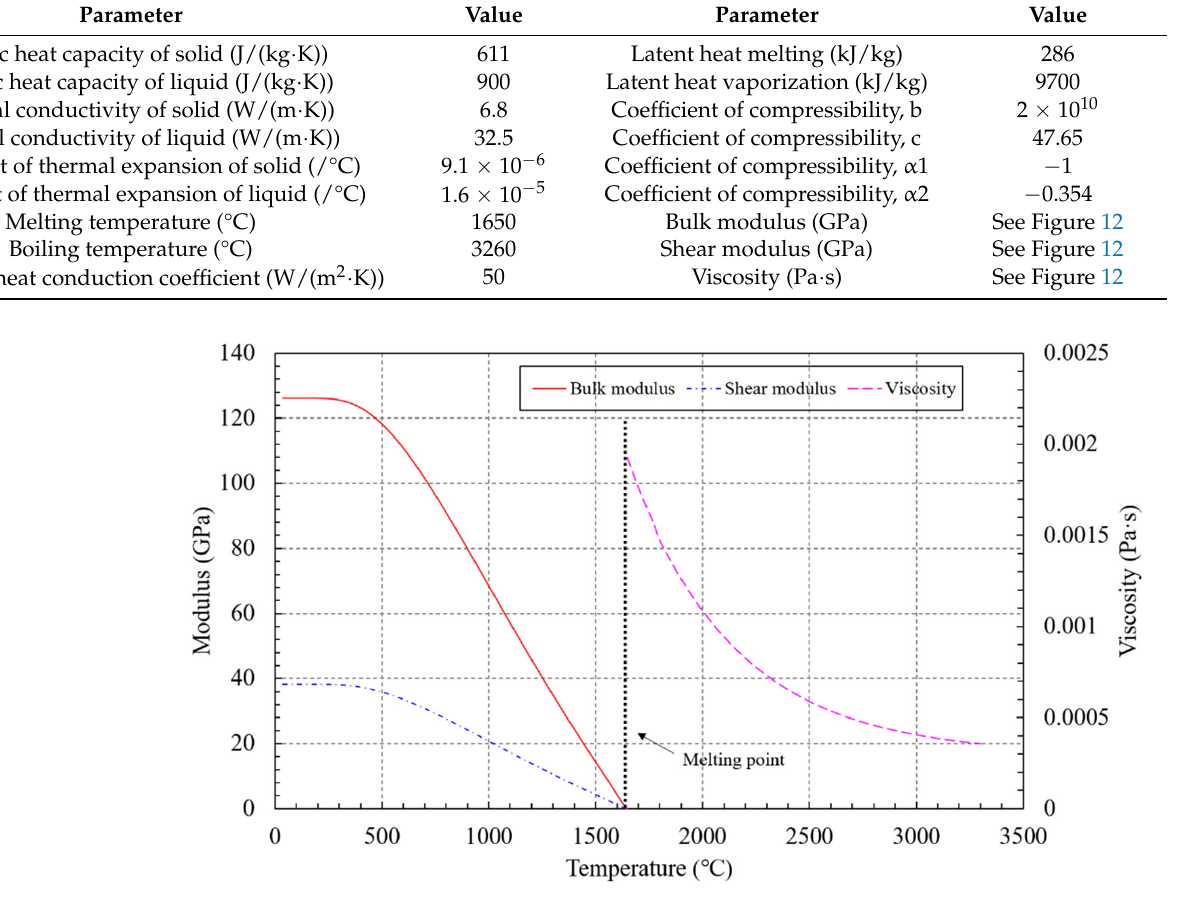
Figure 13. The temperature field distribution in the four ‐ layer cladding process.